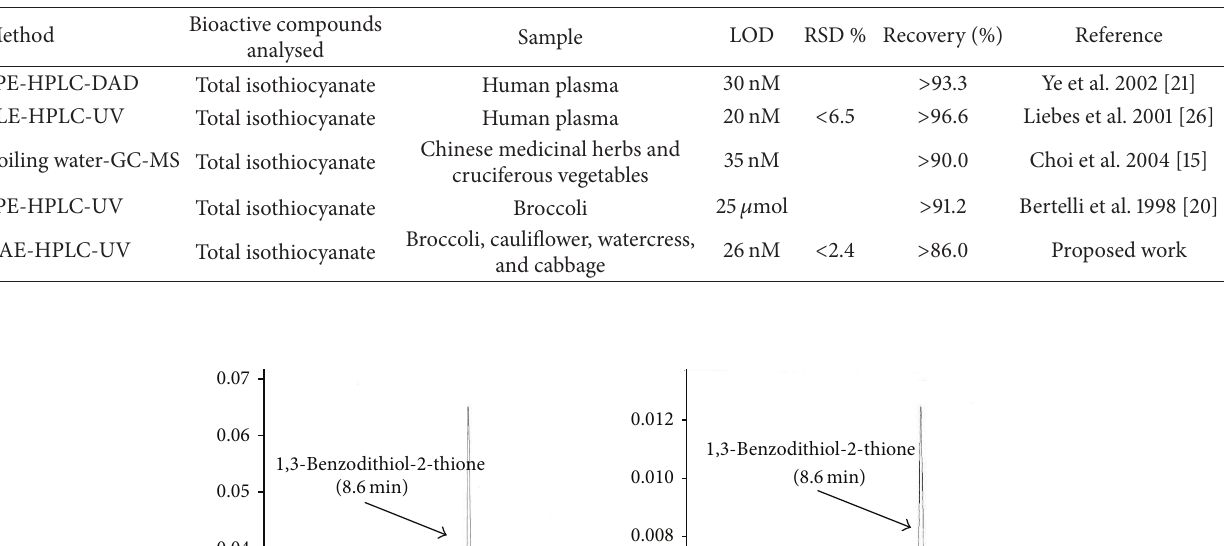
Table 4: Comparison of UAE-HPLC-UV with other analytical methods previously reported for total ITCs determination employing the cyclocondensation reaction.